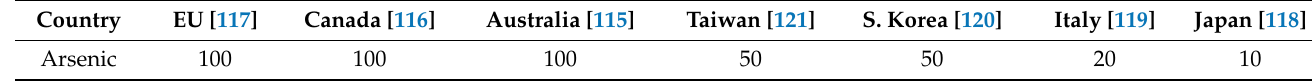
Table 1. The guidelines for arsenic in irrigation water ( µ